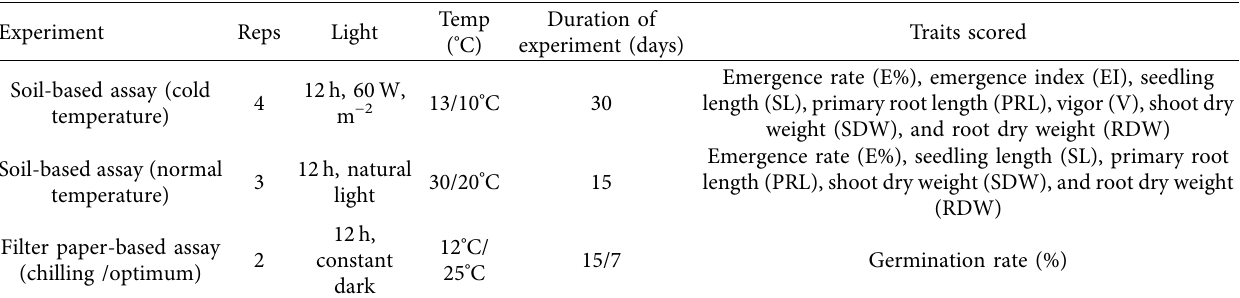
Table 2: Overview of the controlled environment experiments at early development stages.